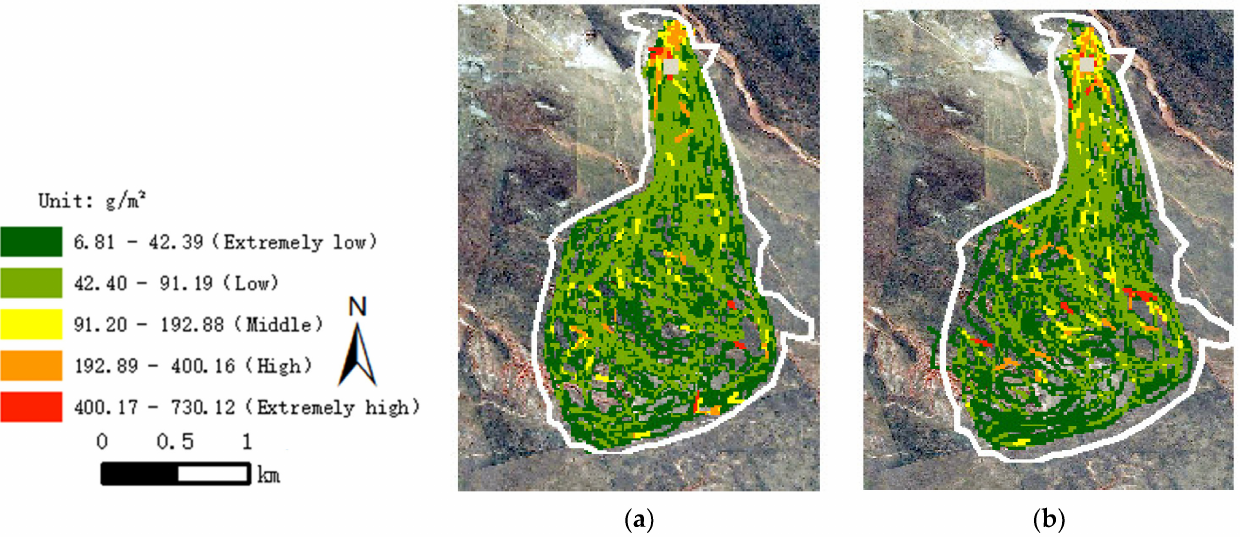
Figure 11. The grazing intensity distribution of sheep in typical months based on neural network model. ( a ) Summer. ( b )